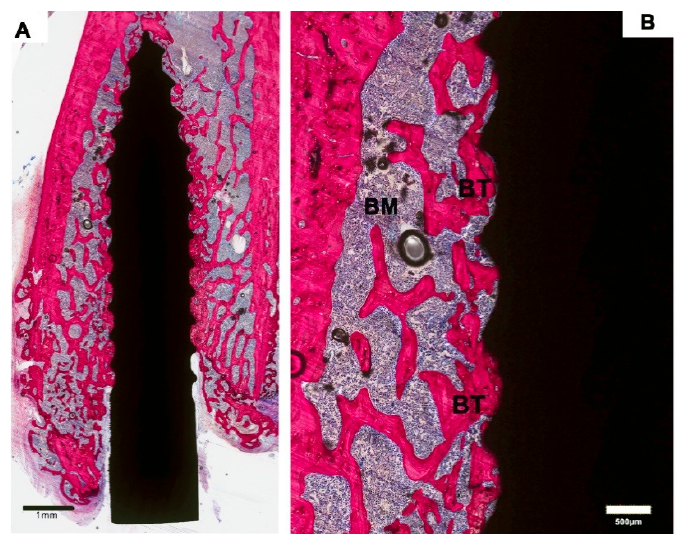
Figure 3. Representative histological images of an implant in the ZOL-Pre study group. ( A ). Low-magnification image showing bone trabeculae surrounding most of the implant. ( B ). Higher magnification revealed that bone was in tight contact with the majority of the implant surface.